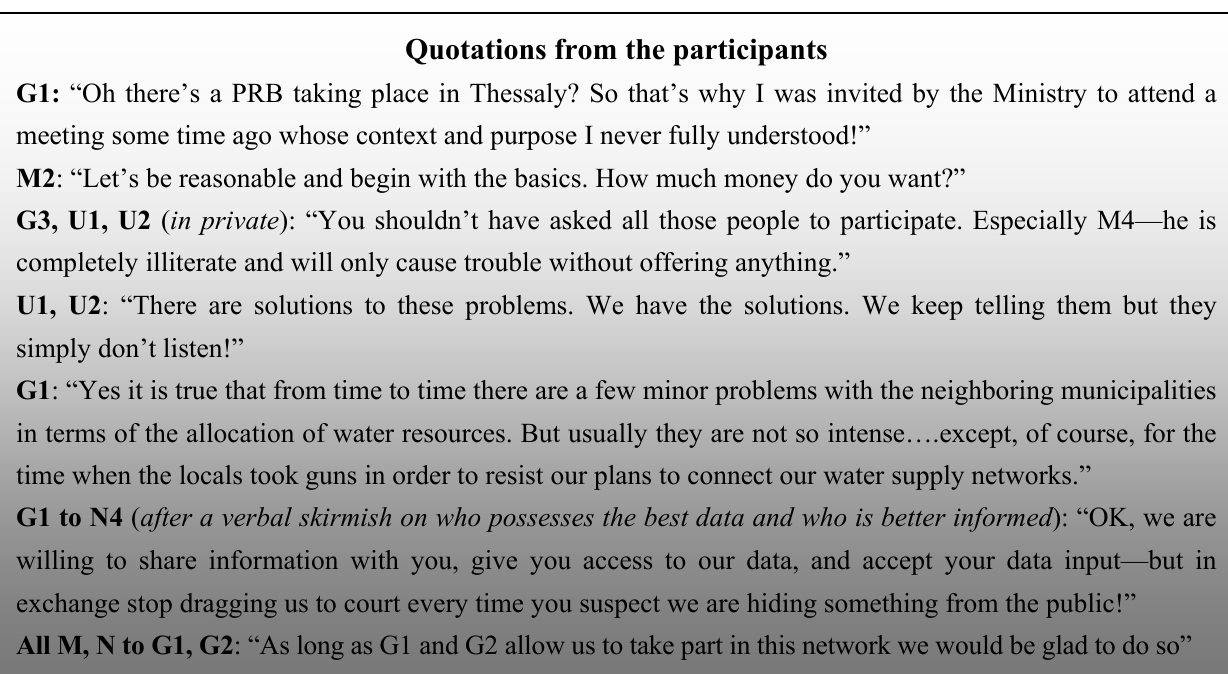
Figure 2. Quotes describing the initial perception of the